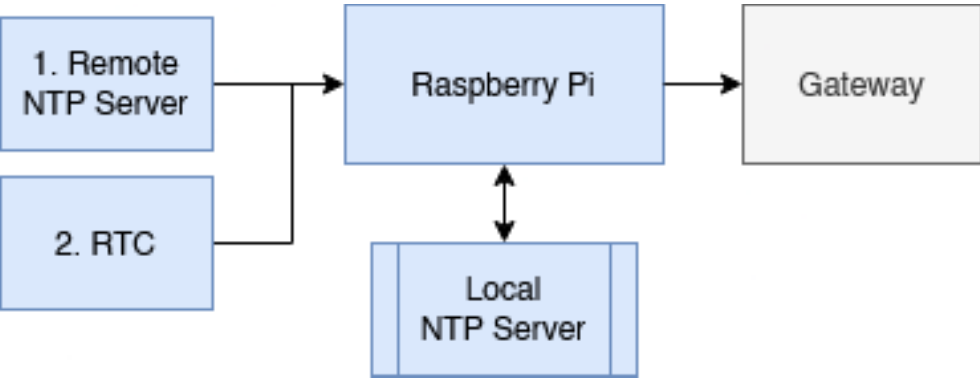
Figure 3. Network time server solution for offline